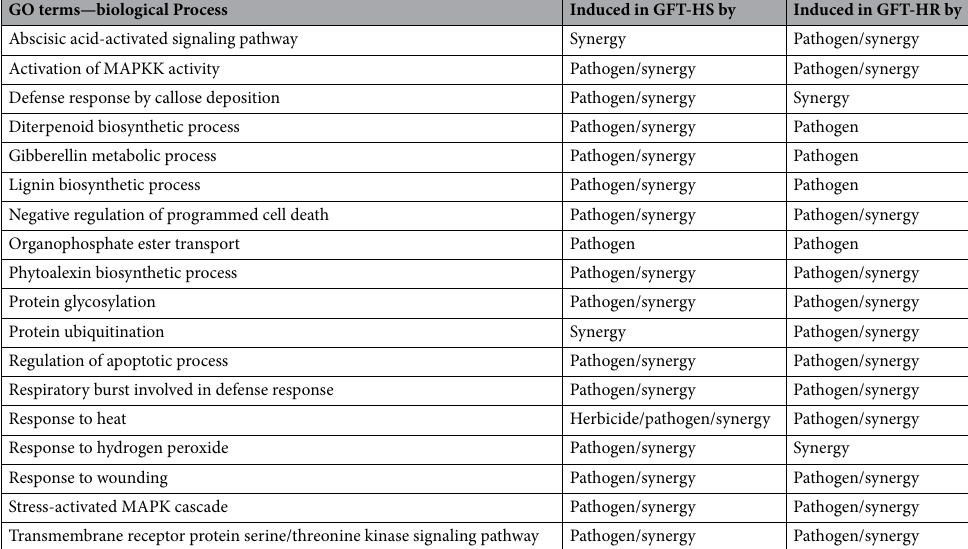
Table 4. Up-regulated biological processes in herbicide-susceptible (HS) and -resistant (HR) biotypes of green foxtail